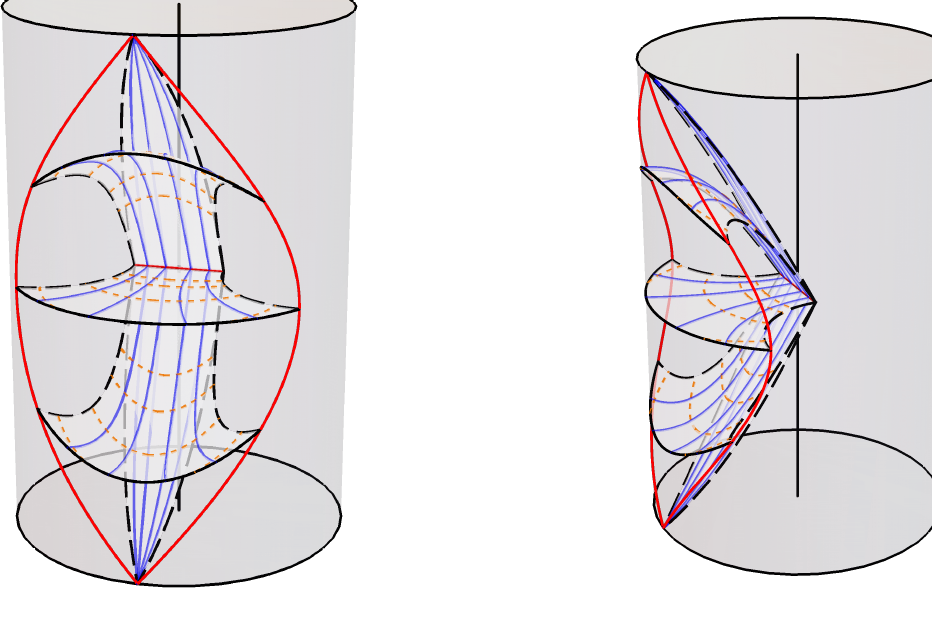
Figure 14 . The Class II right, slow black hole. Several surfaces of constant t are shown. The lines x = x + < y h are shown in dashed black, and are identified with their partner within the same time slice, wrapping the bifurcation surface (shown as a horizontal red line) into a circle. The early and late time-slices demonstrate the event horizon. Lines of constant y are shown in dashed orange. Lines of constant x are shown in blue. The classically accessible region of the boundary is delimited in